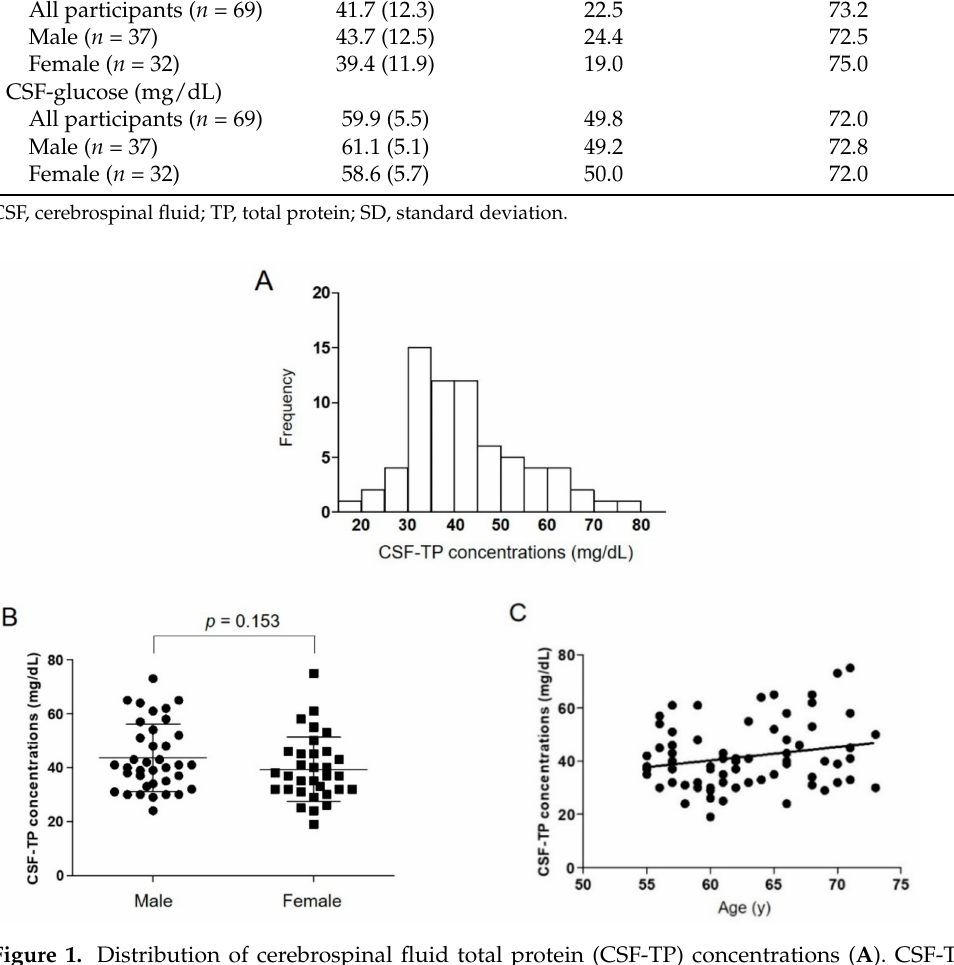
Figure 1. Distribution of cerebrospinal fluid total protein (CSF-TP) concentrations ( A ). CSF-TP concentrations in Japanese healthy older volunteers by sex ( B ). Correlation of age and CSF-TP concentration ( C